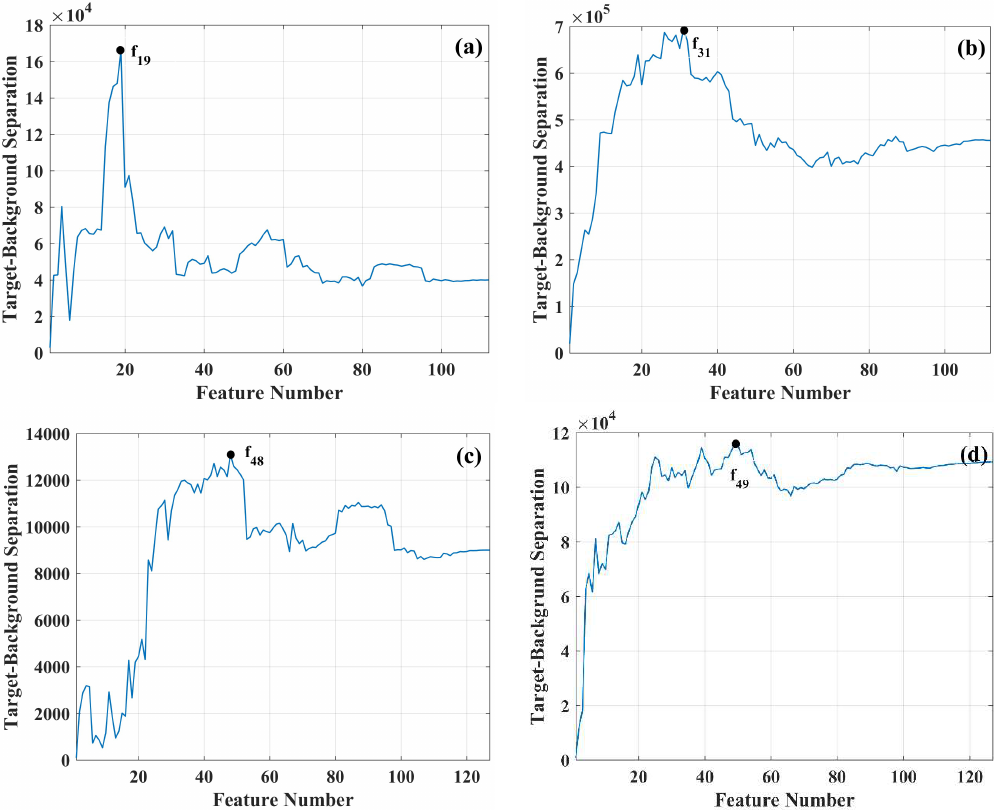
Figure 7. The distance between the target and the background in different feature subsets selected by AFS. The first feature is the first optimal feature and the last feature subset contains all of the selected and sorted features. ( a ) The distance obtained for the first target and ( b ) all targets in the HyMap dataset. ( c ) The distance obtained for the first target and ( d ) all targets in the SIM.GA dataset.